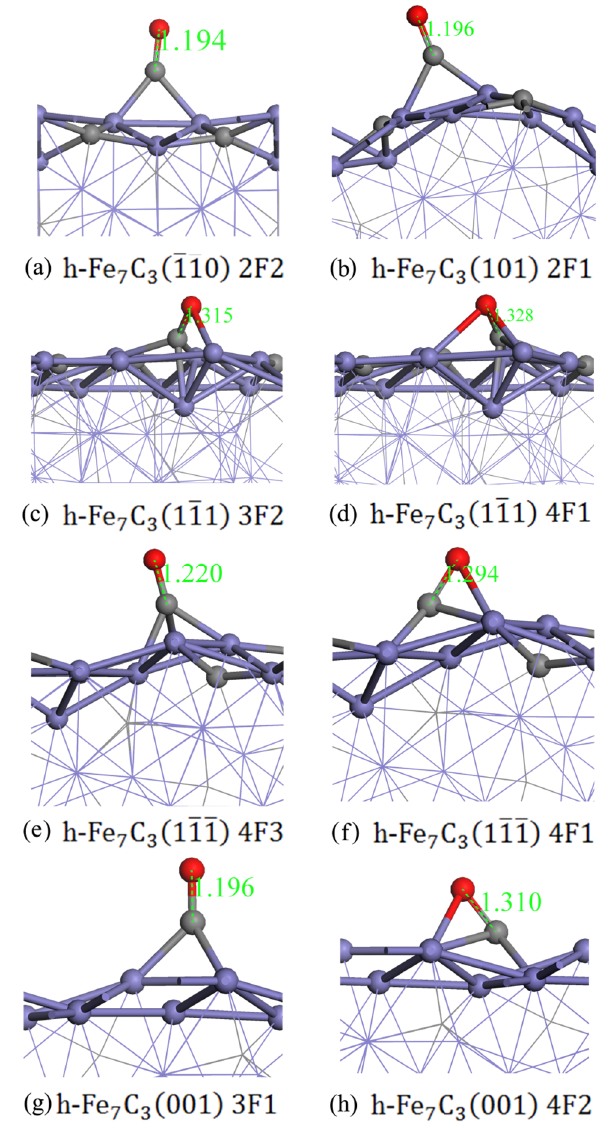
Figure 3. The most stable and active adsorption configuration of CO on various crystal planes of h-Fe 7 C 3 (bond length given in Å) ( a . (11(cid:3364)0) 2F2; b . (101) 2F1; c . (11(cid:3364)1) 3F2; d . (11(cid:3364)1) 4F1; e . (11(cid:3364)1(cid:3364)) 4F3; f . (11(cid:3364)1(cid:3364)) 4F1; g . (001) 3F1; h . (001) 4F2 ).